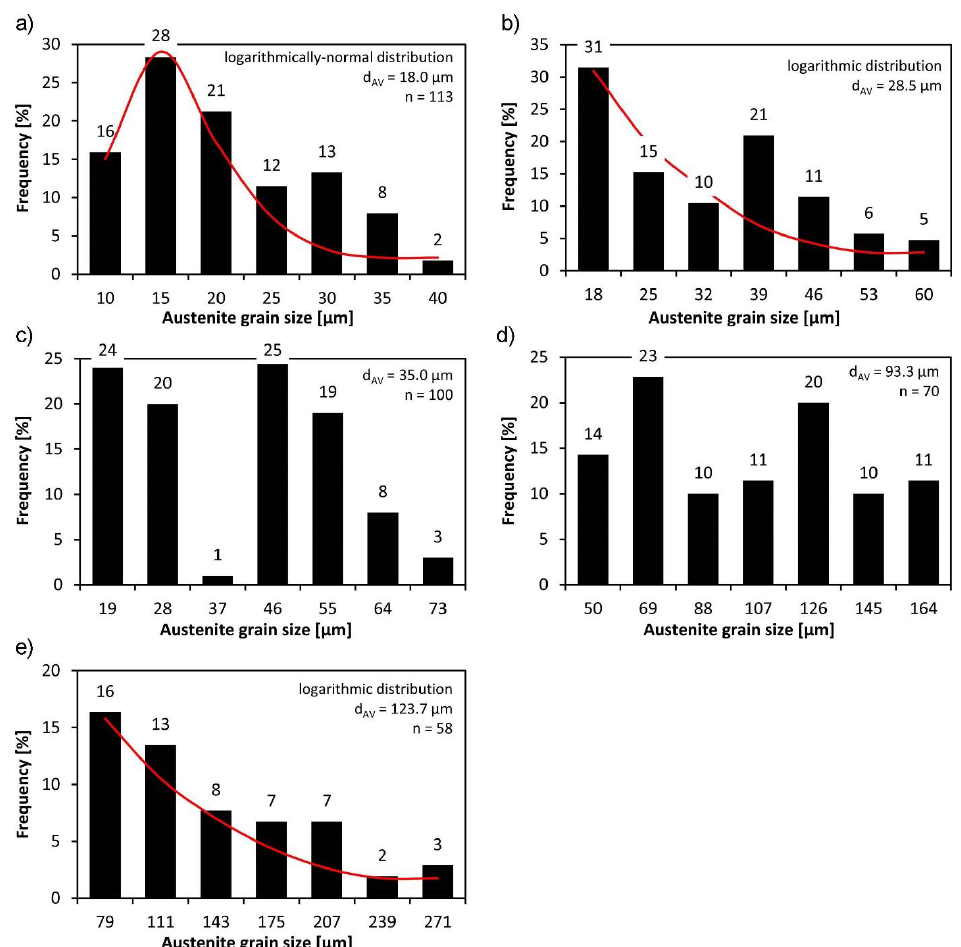
Figure 3. The frequency of occurrence of austenite grain size of the tested steel: ( a ) in the as-received state; ( b ) after austenitizing at 900 °C, 20 min; ( c ) after austenitizing at 1000 °C, 20 min; ( d ) after austenitizing at 1100 °C, 20 min; ( e ) 1200 °C, 20 min.